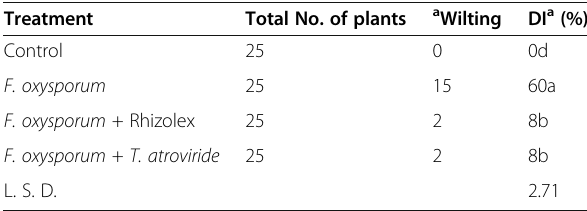
Table 3 Effect of T. atroviride on DI of tomato plants infected by F. oxysporum